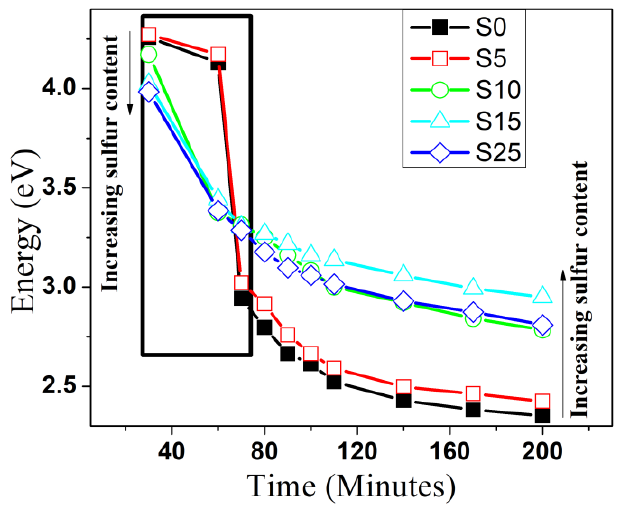
Figure 10. Effect of time on the position of the absorption maximum for the CdSe bare and alloyed structure with different S contents.